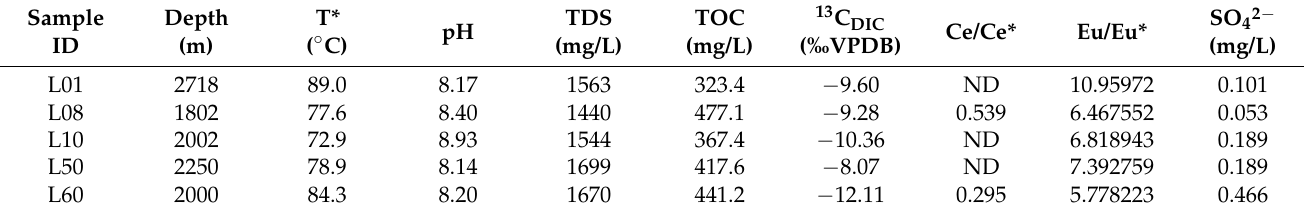
Table 1. Chemical characteristics of the thermal